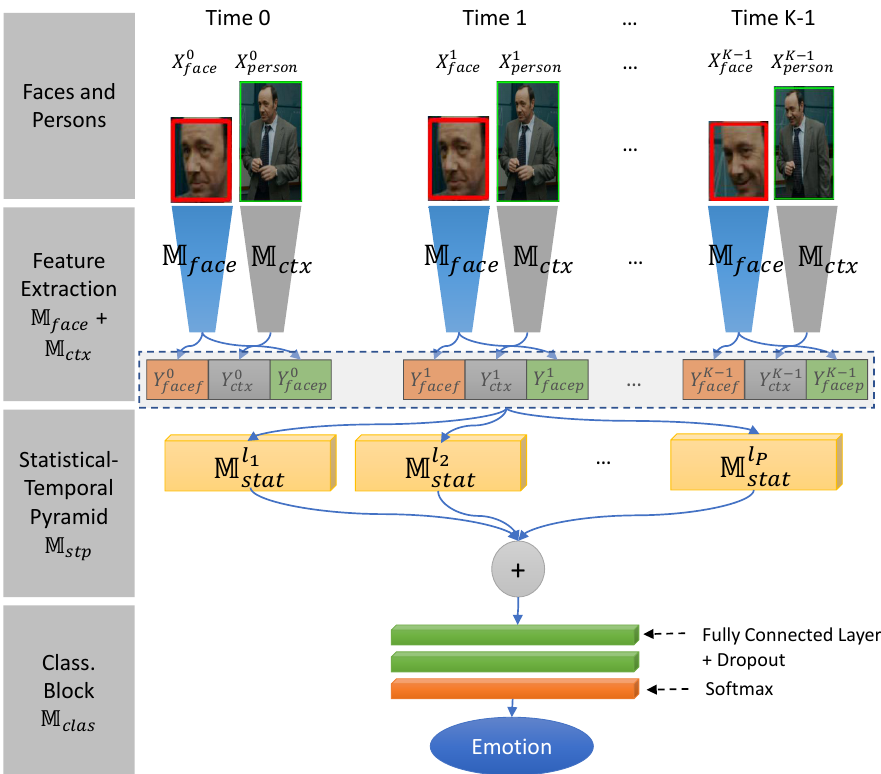
Figure 5. Context Temporal-Pyramid